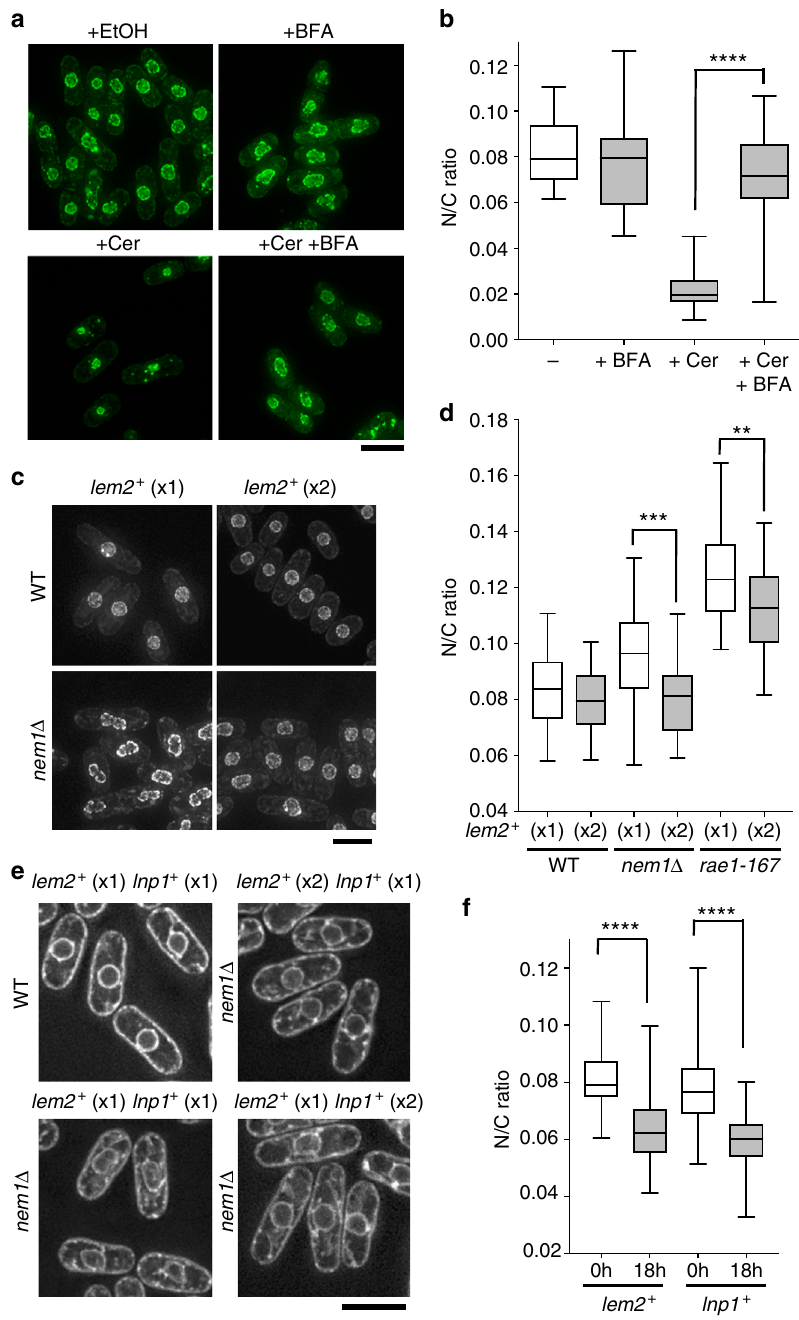
Fig. 3 Lem2 acts as a barrier preventing inappropriate membrane fl ow between the nuclear envelope and ER. a Images of the nuclear envelope (Cut11-GFP, green) of lem2 Δ cells grown at 25°C untreated ( + EtOH) or treated with 10 µ g/ml cerulenin ( + Cer) and/or 100 µ g/ml brefeldin A ( + BFA) for 3h. Maximum intensity projections shown. Cerulenin: 10 µ g/ml, BFA: 100 µ g/ml. Scale bar: 5 µ m. b N/C ratio of lem2 Δ cells (25°C) untreated ( − ) or treated with 10 µ g/ml cerulenin ( + Cer) and/or 100ng/ml brefeldin A ( + BFA) for 3h ( n >30 cells). Two-tailed Mann – Whitney test: **** P <0.0001, lem2 Δ + Cer ( n = 31 cells), lem2 Δ + Cer + BFA ( n = 32 cells). The corresponding dot plot is available in Supplementary Fig. 9c. c Images of the nuclear envelope (Cut11-GFP, grayscale) of wild type (WT) and nem1 Δ cells containing one or two copies of the gene encoding Lem2 grown at 25°C. Scale bar: 5 µ m. d N/C ratio of wild type (WT), nem1 Δ and rae1- 167 cells containing one or two copies of the gene encoding Lem2 ( n >30 cells). Two-tailed t- tests: *** P = 0.001, nem1 Δ + 1× lem2 + ( n = 31 cells) against nem1 Δ + 2× lem2 + ( n = 40 cells), t = 4.129, degrees of freedom = 69; ** P = 0.0015, rae1-167 + 1× lem2 + ( n = 43 cells) against rae1-167 + 2× lem2 + ( n = 35 cells), t = 3.297, degrees of freedom = 76. WT and nem1 Δ cells grown at 25°C. Temperature-sensitive rae1-167 cells grown at 25°C then shifted to 36°C for 4h before imaging. The corresponding dot plot is available in Supplementary Fig. 9d. e Representative images of the ER lumen (GFP-ADEL) of wild type (WT) cells and nem1 Δ cells containing one or two copies of genes encoding Lem2 or Lnp1 grown at 25°C. Scale bar: 5 µ m. f N/C ratio of wild type (WT) cells overexpressing lem2 + or lnp1 + (under control of the nmt1 promoter) grown in minimal medium (EMM) at 28°C for 0 or 18h ( n >30 cells). Two-tailed Mann – Whitney test: **** P <0.0001, lem2 + (0h) ( n = 42 cells) against lem2 + (18h) ( n = 35 cells); lnp1 + (0h) ( n = 48 cells) against lnp1 + (18h) ( n = 48 cells). The corresponding dot plot is available in Supplementary Fig. 9e. In all box-and-whiskers diagrams, boxes indicate median and upper and lower quartile and whiskers indicate range of